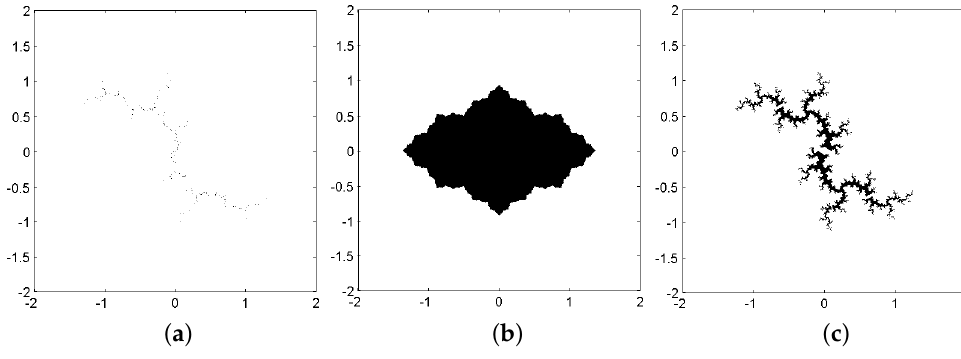
Figure 1. The leader Julia set of z ( n + 1 ) = z 2 ( n ) + c when c = − 1.